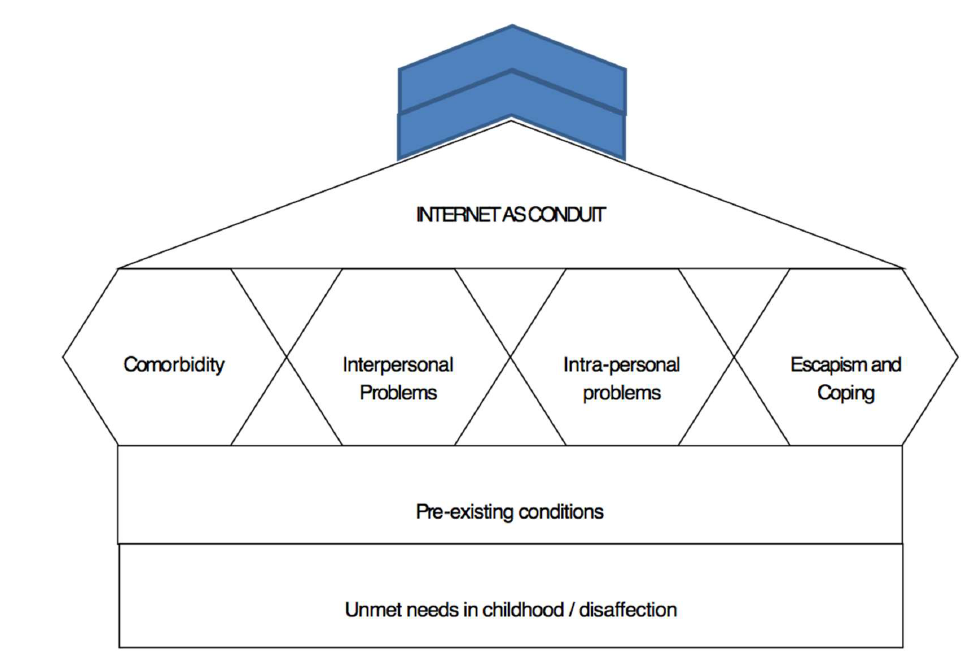
Figure 1 The Internet Addiction Aetiology Model Shorrock